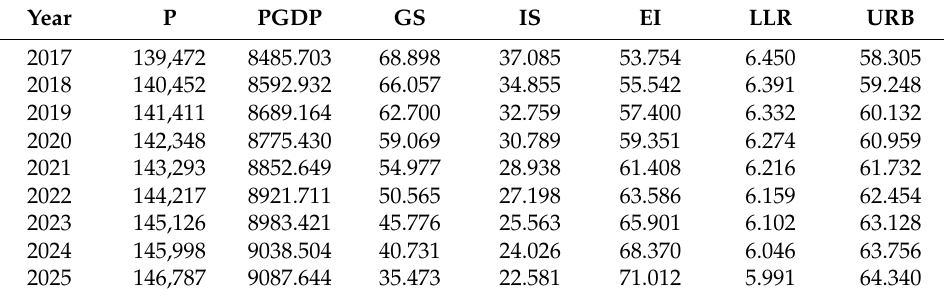
Table 9. The forecasting results of driving factors from 2017 to 2025.